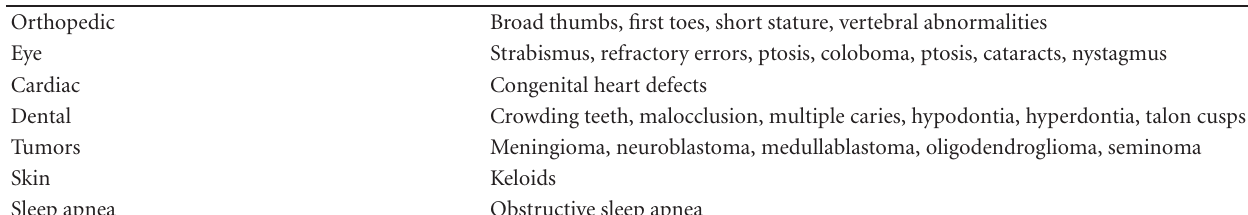
Table 1: Characteristics of RTS.